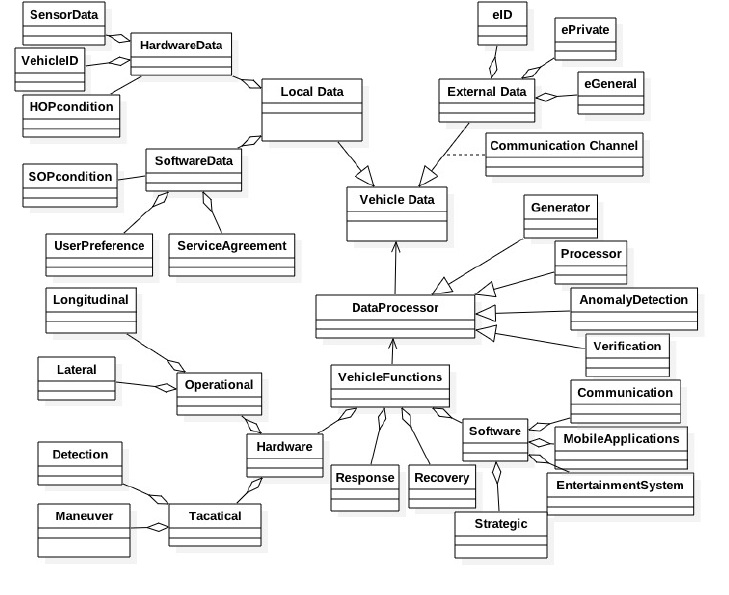
Figure 2. Unified Modelling Language (UML)-based CAV